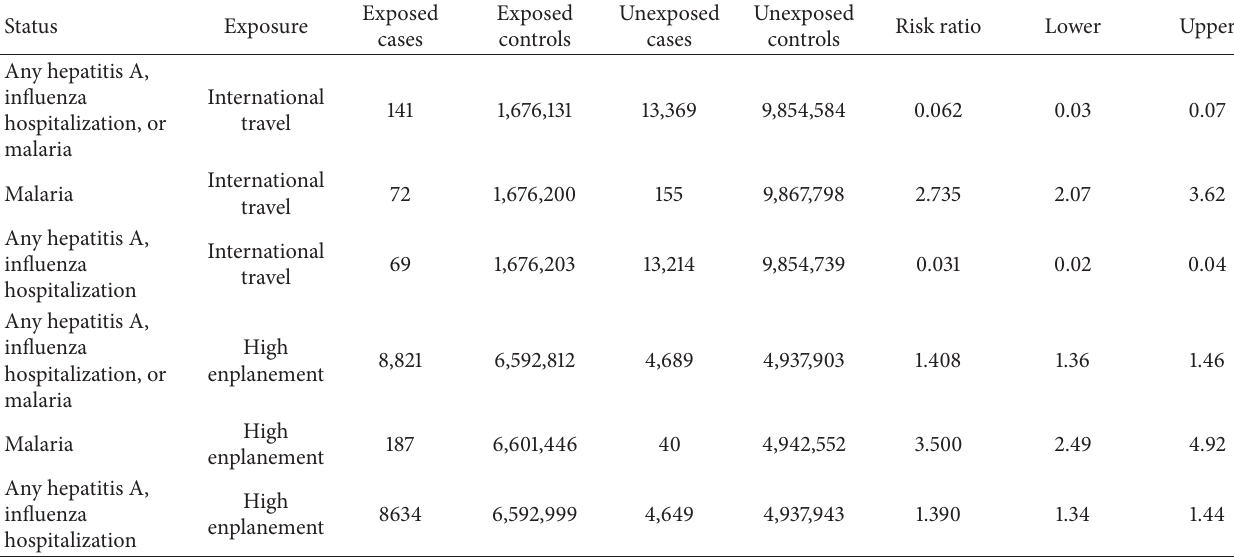
Table 1: Risk ratios of infectious diseases by exposure to high enplanement or international air travel in Ohio from 2010 through 2014 (total population = 11,544,225) with 95% confidence intervals.